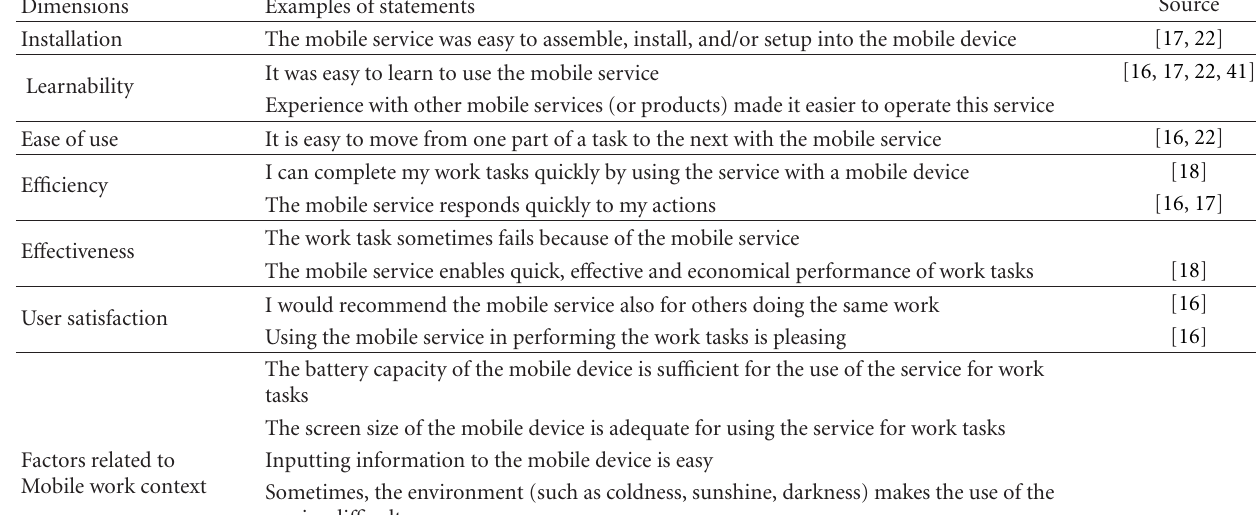
Table 1: The dimensions for the questionnaire on the success of mobile business services and examples of